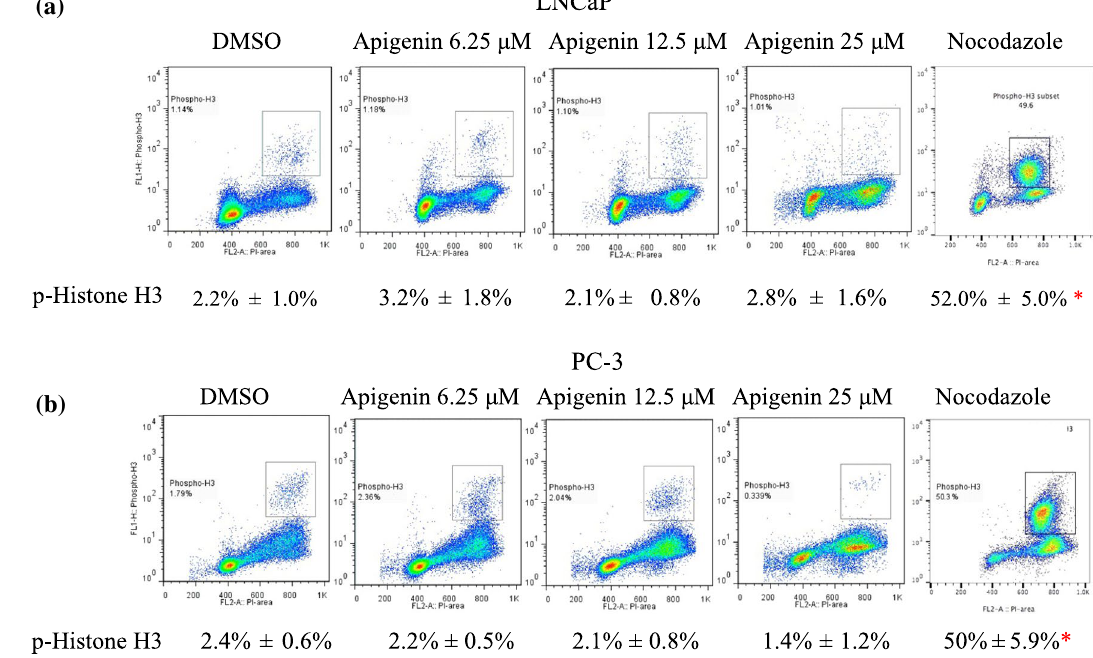
Fig. 3 Apigenin increased prostate cancer cells at G phase. a LNCaP and b PC-3 cells were treated with apigenin at indicated doses for 72 h 2 and labeled with both an antibody against phospho-Histone H3 and PI for detection of miotic cells. To enrich mitotic cells as reference, the cancer cells were treated with nocodazole (0.8 µg/mL) for 16 h. The percentages of miotic cells were expressed as the mean ± SD from three independent experiments. *p < 0.05 compared to